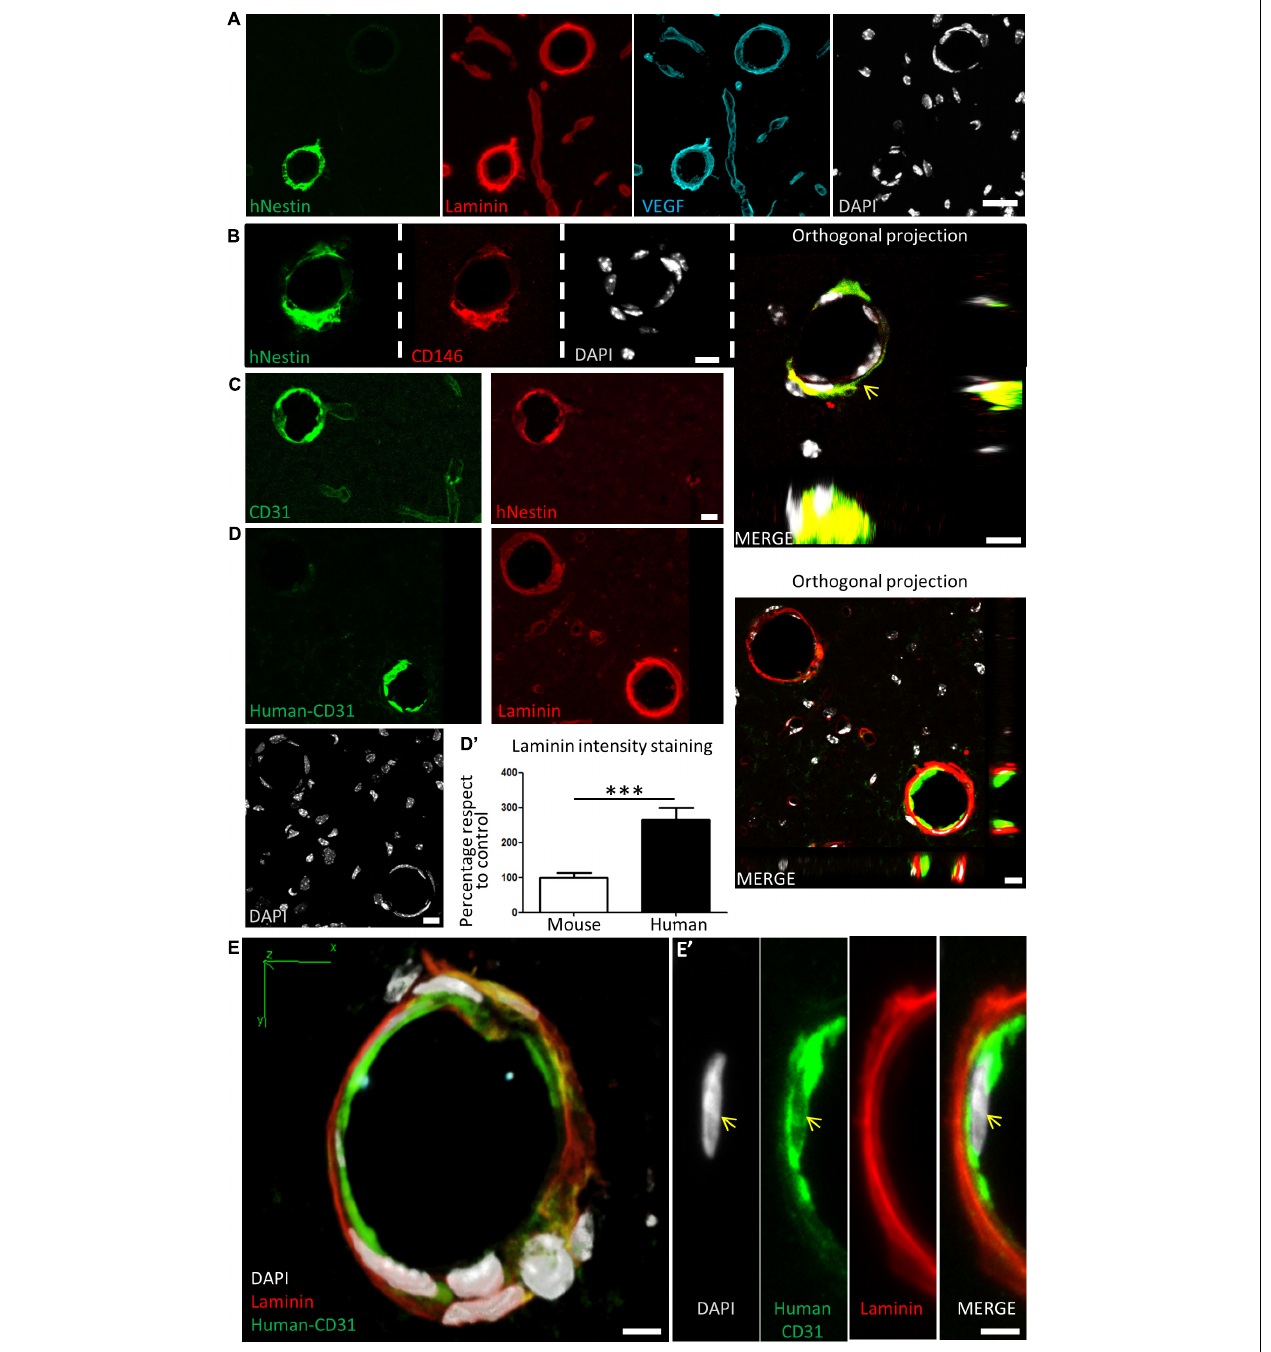
FIGURE 7 | Human DPSCs survive after 1-month post graft into the brain of nude mice, expressing CD31 and VEGF and integrating into the host brain vasculature. (A) Detail of human Nestin-positive DPSC-derived cells covering brain vasculature showed an increase in the staining for laminin and VEGF, suggesting de novo vasculature formation. (B) Triple staining and orthogonal projection of human-Nestin, CD146, and DAPI shows human pericytes wrapping around the endothelial murine (DAPI) cells (arrow). Scale bar 10 µ m. (C) CD31 staining for both murine and human endothelial cells colocalizes with human Nestin-positive DPSC-derived cells in some medium caliber blood vessels, showing their human origin. (D) A specific antibody for human-CD31 cells recognizes human DPSC-derived endothelial cells within some of the blood vessels, which precisely correspond to the ones showing an increased laminin staining. Scale bar of images and orthogonal projection 10 µ m. (D’) Quantification of laminin staining intensity for murine blood vessels and blood vessels containing human DPSC-derived endothelial cells (mean ± SEM n = 30 and 35 blood vessels, respectively, for n = 4 grafted animals, ∗∗∗ p = 0.0001, one-tailed Mann–Whitney test). Scale bar 20 µ m. (E) 3D-reconstruction from a 10- µ m thick cryostat slice showing human-CD31 endothelial cells in the inner wall of a blood-vessel decorated with laminin staining. Scale bar 5 µ m. (E’) Close detail of a human-CD31 positive cell showing the elongated nuclear morphology characteristic of endothelial cells (arrows). Scale bar 5 µ m.